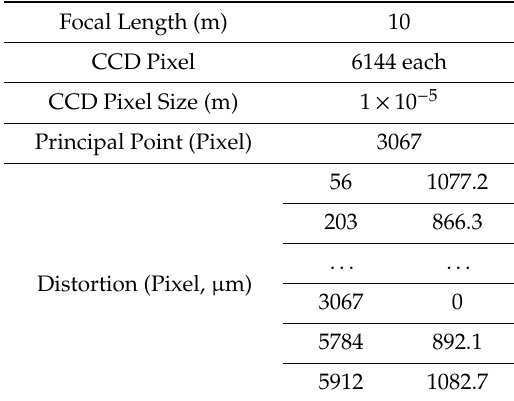
Table 2. Star Camera Parameters.